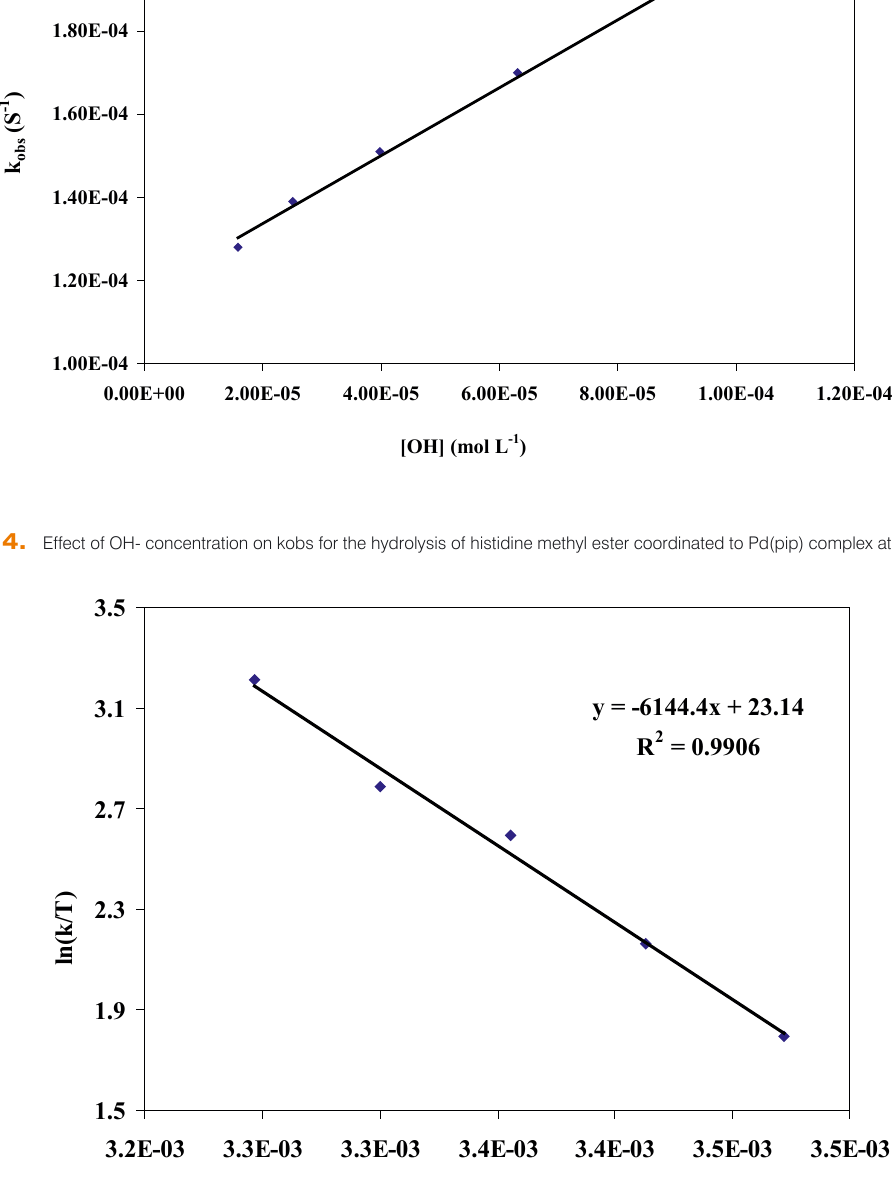
Figure 5. Effect of temperature on the hydrolysis of glycine methyl